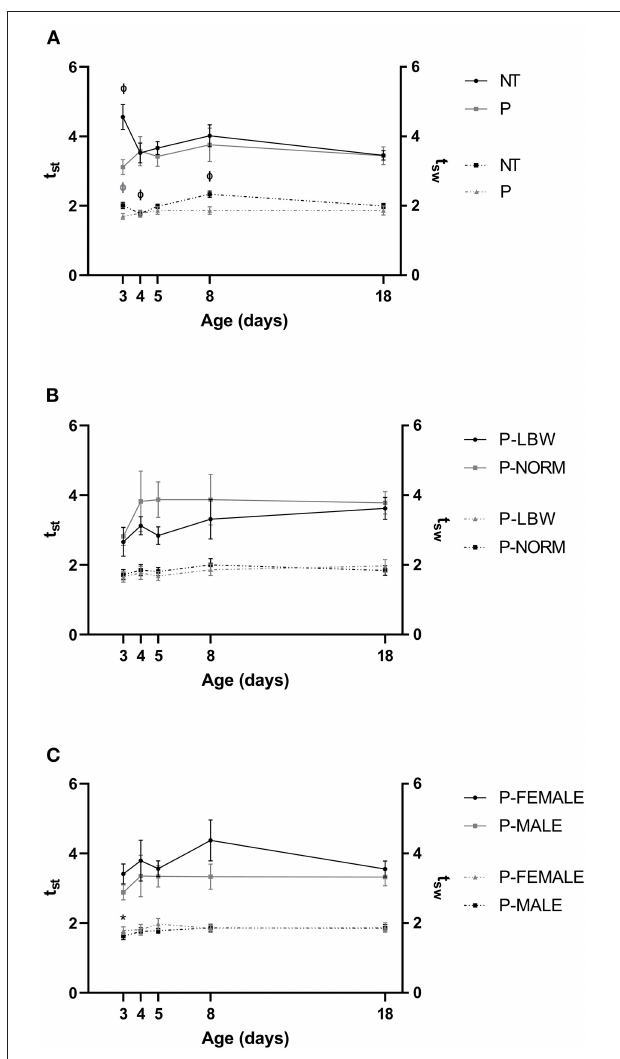
FIGURE 3 | Normalized stance and swing duration. All values are mean (A) Normalized stance duration ( t ′ st ; full line) and swing duration (t ′ sw ; dotted line) according to condition (P: preterm, gray; T: term, black) and age. Mean values for t ′ st at d3 and t sw ′ at d3, d5, d8, and d18 were higher in T than in P. Mean values of t ′ st and t sw ′ indicated with “ Φ ” were different from d18. (B) Normalized stance duration ( t ′ st ; full line) and swing duration ( t ′ sw ; dotted line) according to birth weight (normal birth weight (P-NORM); low birth weight (P-LBW) and postnatal age. t ′ st was higher in P-NORM compared to P-SGA. (C) Normalized stance duration ( t ′ st ; full line) and swing duration (t ′ sw ; dotted line) according to sex (female: P-FEMALE; male: P-MALE) and postnatal age. t ′ st was higher in P-FEMALE compared to P-MALE. Mean values of t sw ′ indicated with “*” were different from d18. Black colors indicate differences in T while gray colors indicate differences in P